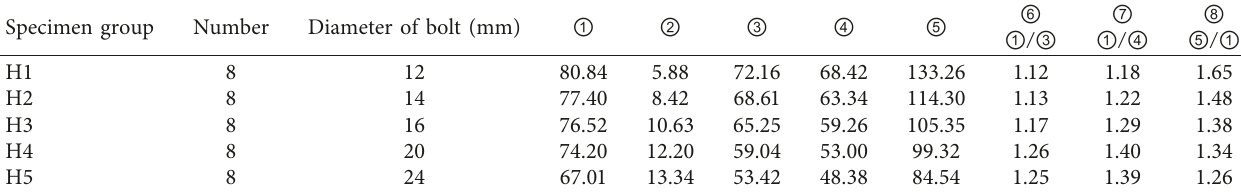
Table 1: Tested result.